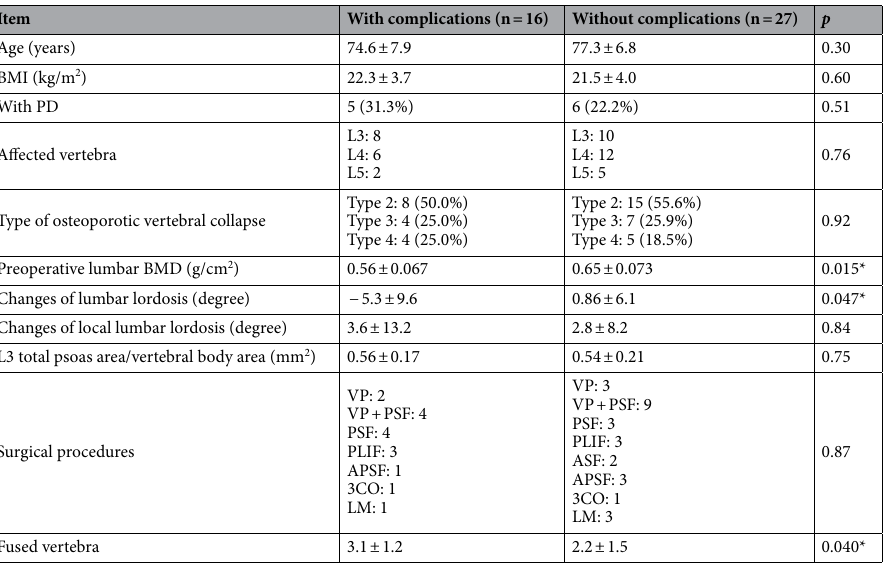
Table 5. Factors in postoperative complications related to instrumentation failures. BMI Body mass index, PD Parkinson disease, BMD Bone mineral density, VP Vertebroplasty, PSF Pedicle screw fixation, PLIF Posterior lumbar interbody fusion, ASF Anterior spinal fusion, APSF Anterior and posterior spinal fusion, 3CO 3 Column osteotomy, LM laminotomy. * p <